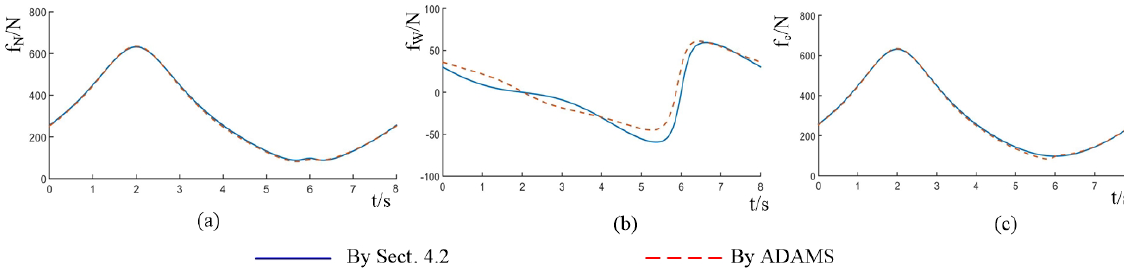
Figure 13. Reaction forces of the prismatic joints: (a) f N , (b) f W , (c) f C .